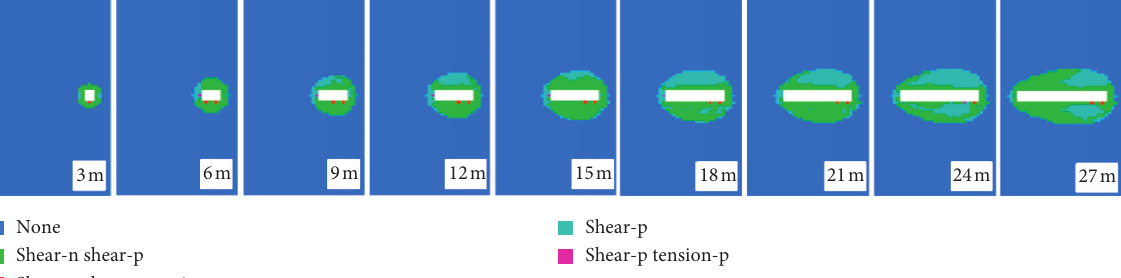
Figure 12: Distribution law of plastic zone.